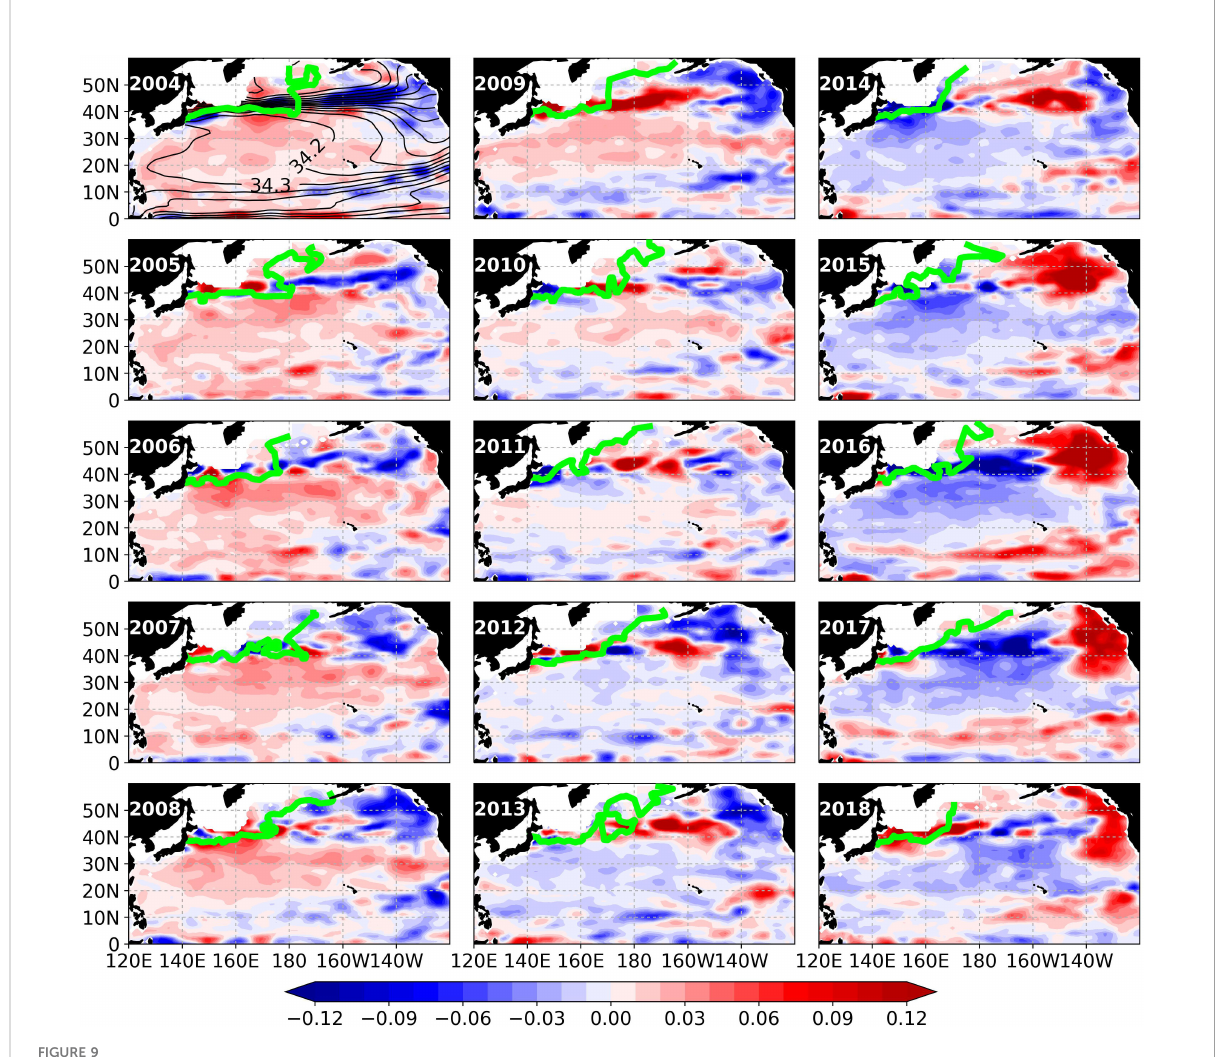
FIGURE 9 Same as in Figure 8 but on 26.3 g surface with labels of 34.2 and